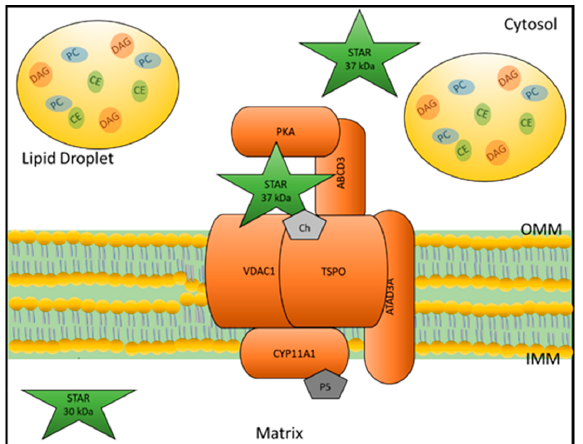
Figure 1. Function of hormone-induced STAR and constitutive STAR. Hormonal stimulation in- duces STAR to localize to the OMM where it interacts and works with other transduceosome proteins to transport cholesterol to CYP11A1 at the IMM for acute steroidogenesis. CYP11A1 converts cholesterol to the first steroid, pregnenolone. Upon reaching the OMM, the mitochondrial targeting sequence of STAR is cleaved, inactivating the protein, and inducing its import into the matrix. Constitutive STAR plays a role in the transport and/or metabolism of cholesteryl esters, diacylglycerol, and phosphatidylcholine as knockout of STAR results in the accumulation of these lipids. Abbreviations: Ch: